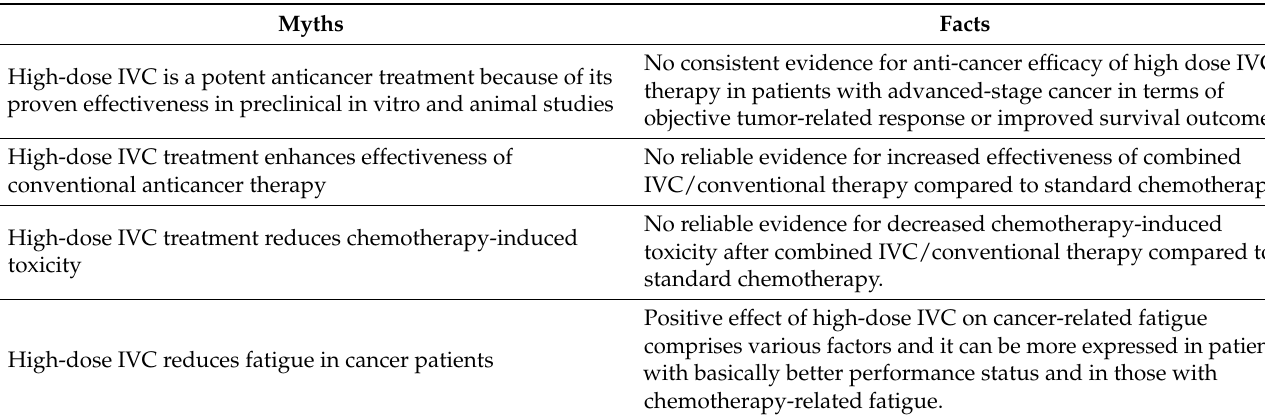
Table 4. Facts and myths about high-dose intravenous vitamin C (IVC) effectiveness in advanced-stage cancer patients.